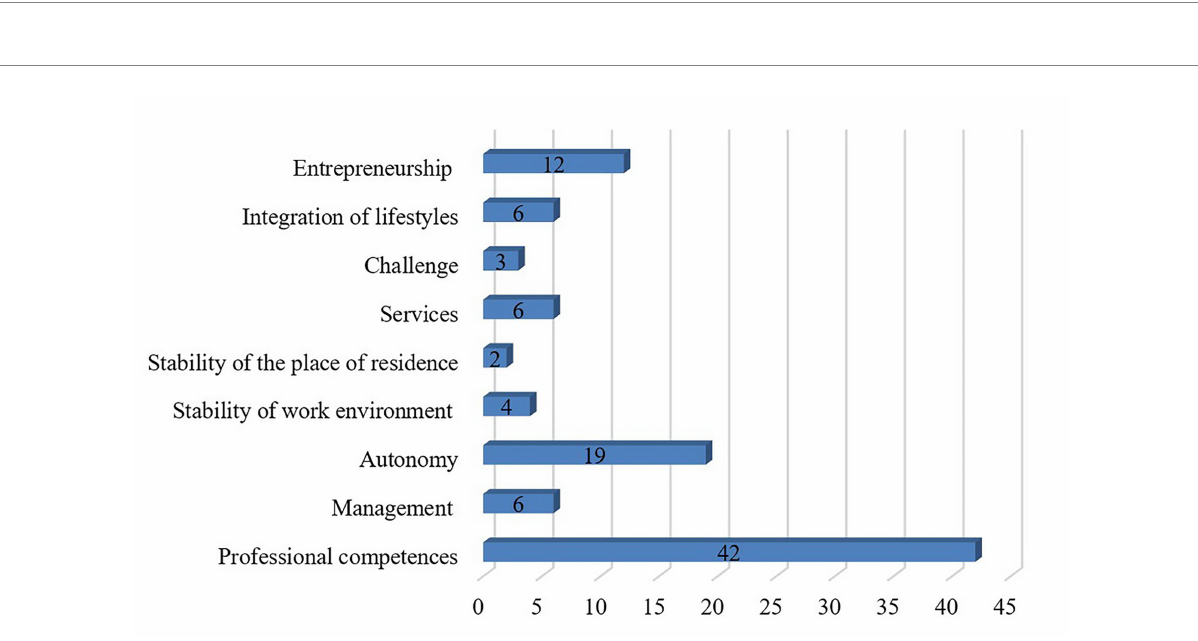
FIGURE 5 Career value orientations